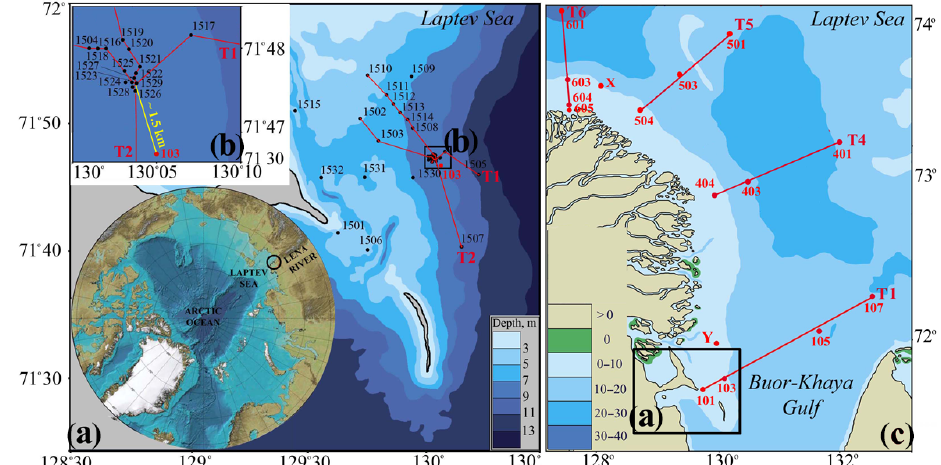
Figure 2. (a) Study area in winter, (b) detail of winter observation sites. Yellow line and number is the approximate distance between winter (no. 1529) and summer (no. 103) stations. (c) Study area in summer. Black dots – location and numbers of winter oceanographic stations, red dots – location and numbers of summer oceanographic stations, red lines – oceanographic transects of temperature, salinity and their numbers. Background map modified from IBCAO